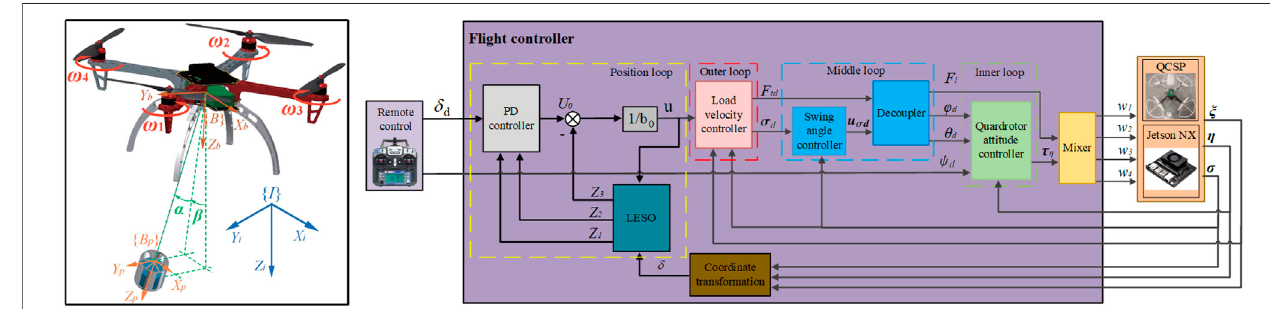
FIGURE 1 | The schematic diagram and the control block diagram of the